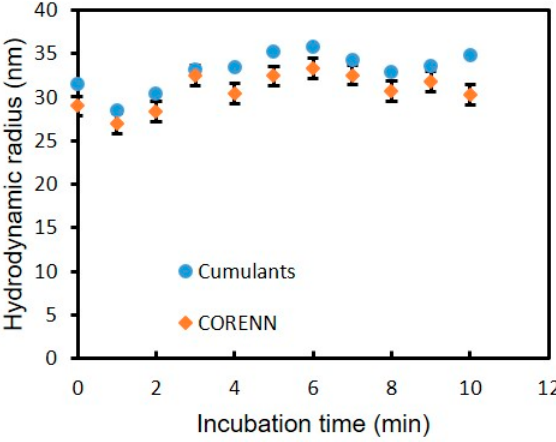
Figure 5. Gold nanospheres together with mouse serum (2.3%). Cumulants and CORENN results.